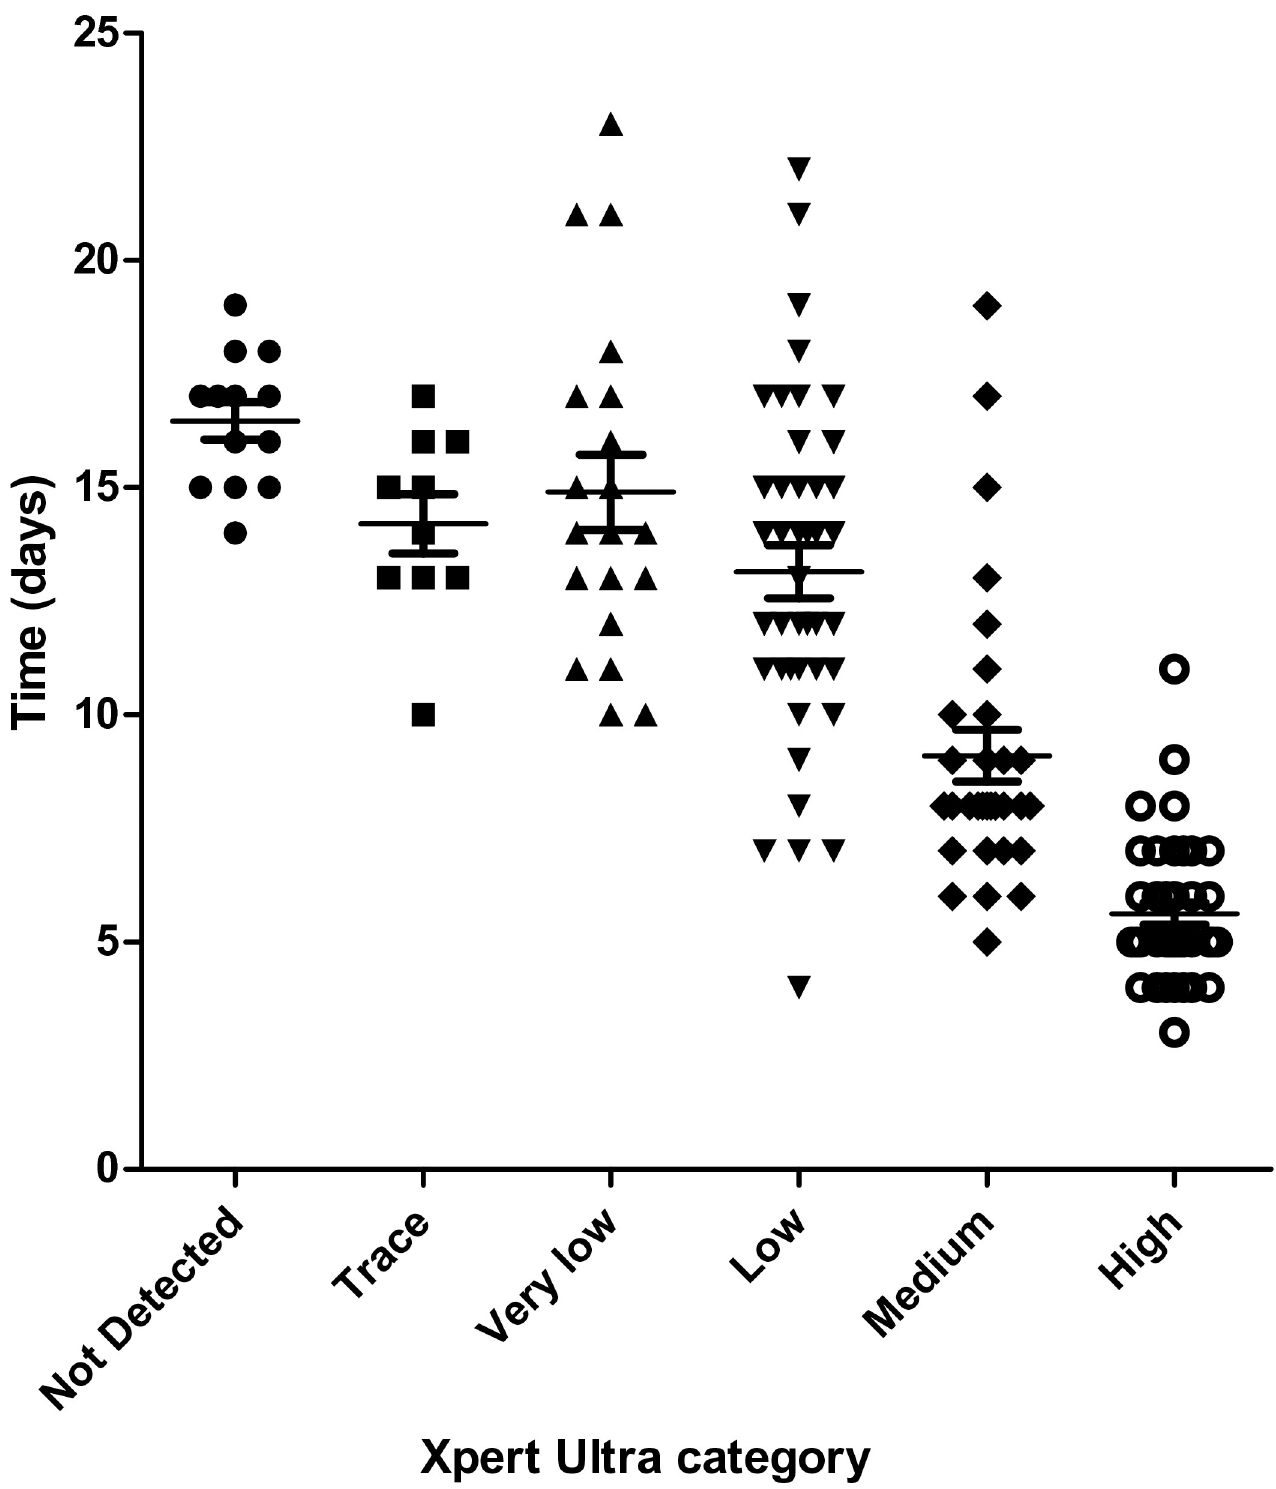
Fig 2. Correlation between Xpert Ultra categories and time to positivity of MTBc culture. P < 0,0001.